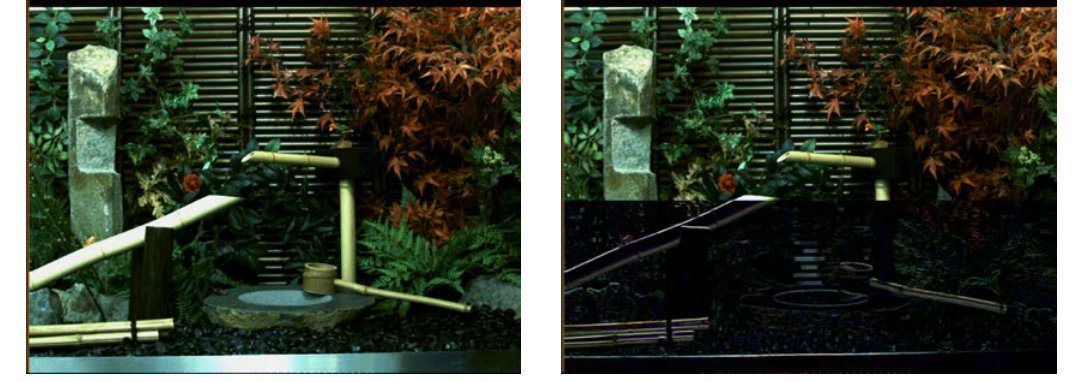
Figure 16. Results of spatial filtering (area selected). ( a ) without filtering; ( b ) with Sobel filtering applied only to the lower half of the image.